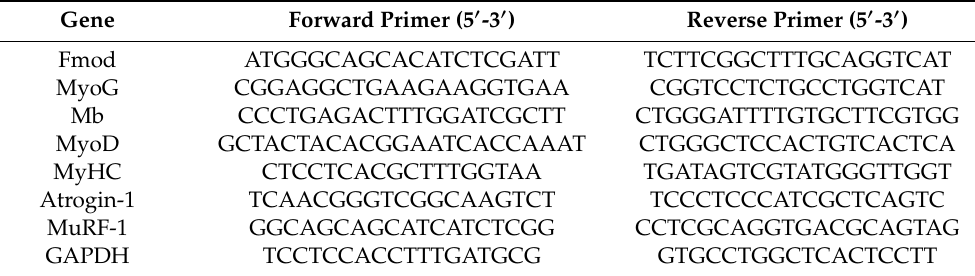
Table 1. Gene-specific primers for